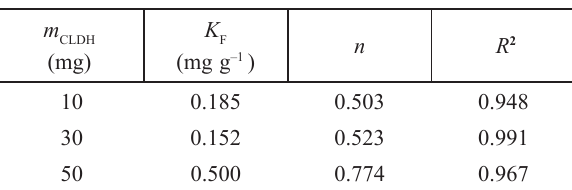
Table 4 – Parameter values of Freundlich isotherm model for adsorption of CA by